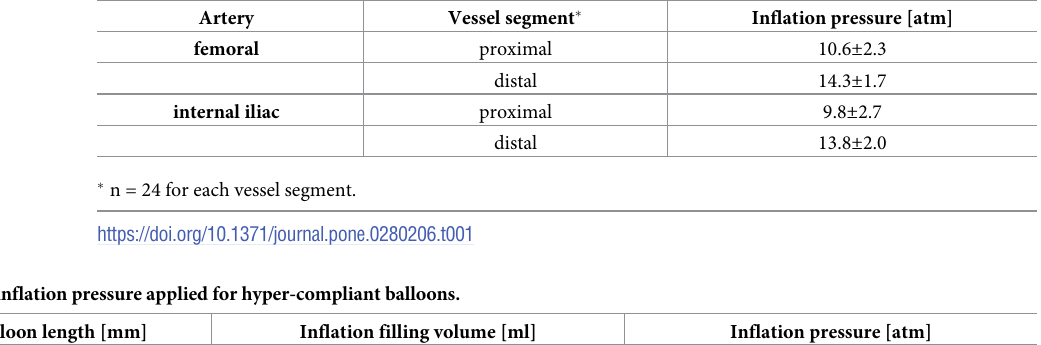
Table 1. Inflation pressure applied for stent implantation in porcine peripheral arteries.